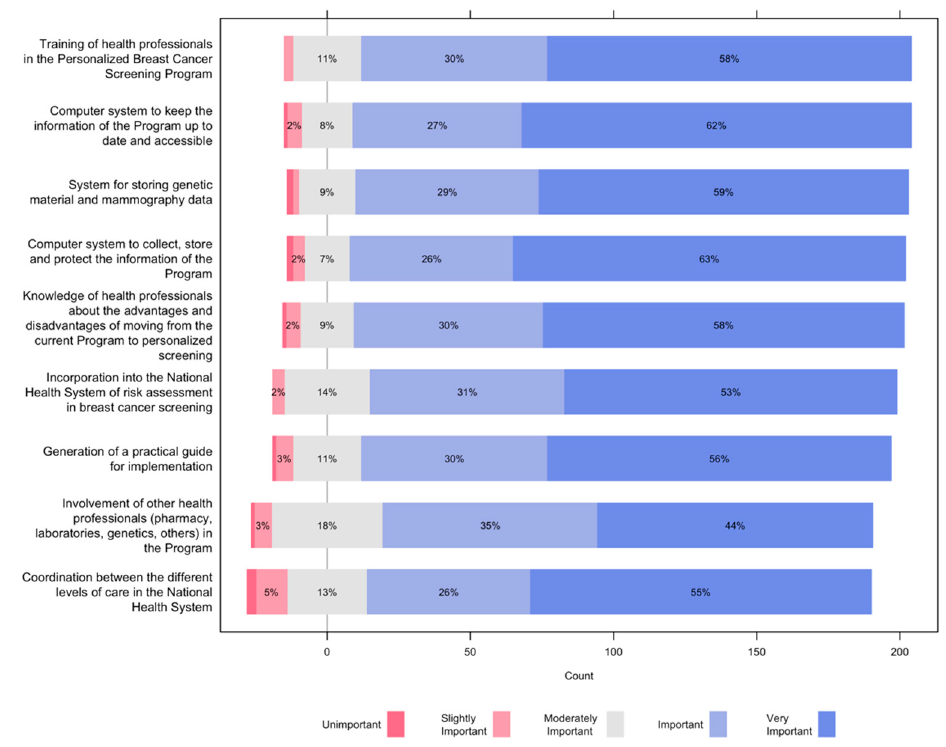
Figure 7. Opinions of the study participants on aspects of the organizational structure to consider for the implementation of risk-based screening.